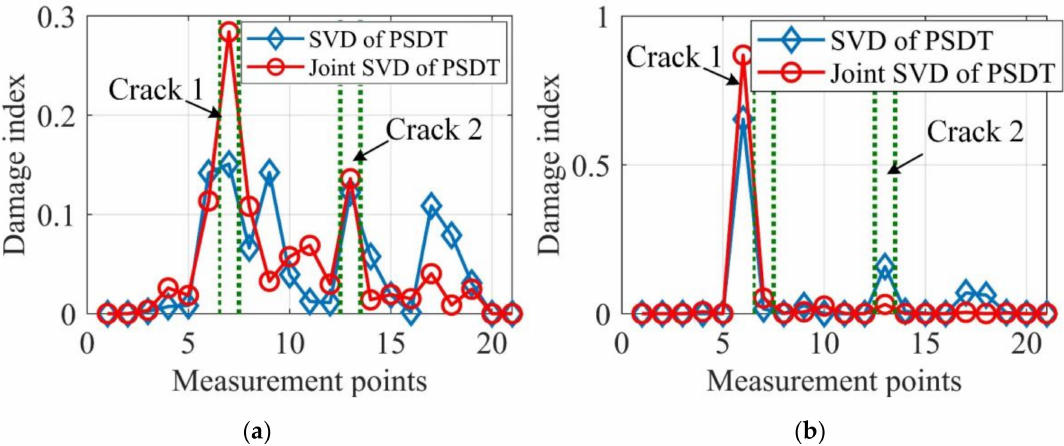
Figure 11. Integrated damage indexes of experimental case 1. ( a ) Proposed data fusion approach; ( b ) Bayesian fusion.